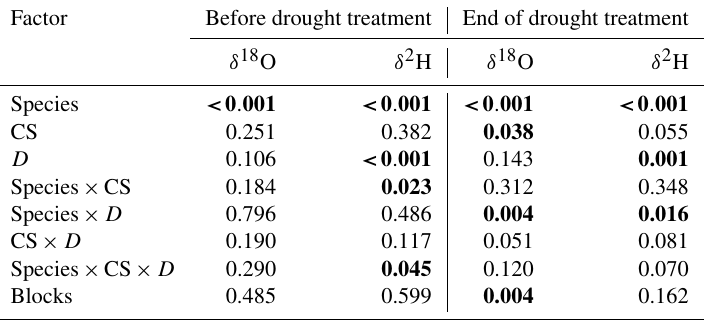
Table 3. Effects of the species (df = 1), cropping system (CS, df = 3), drought treatment ( D , df = 1), and interaction (species × CS, df = 3;